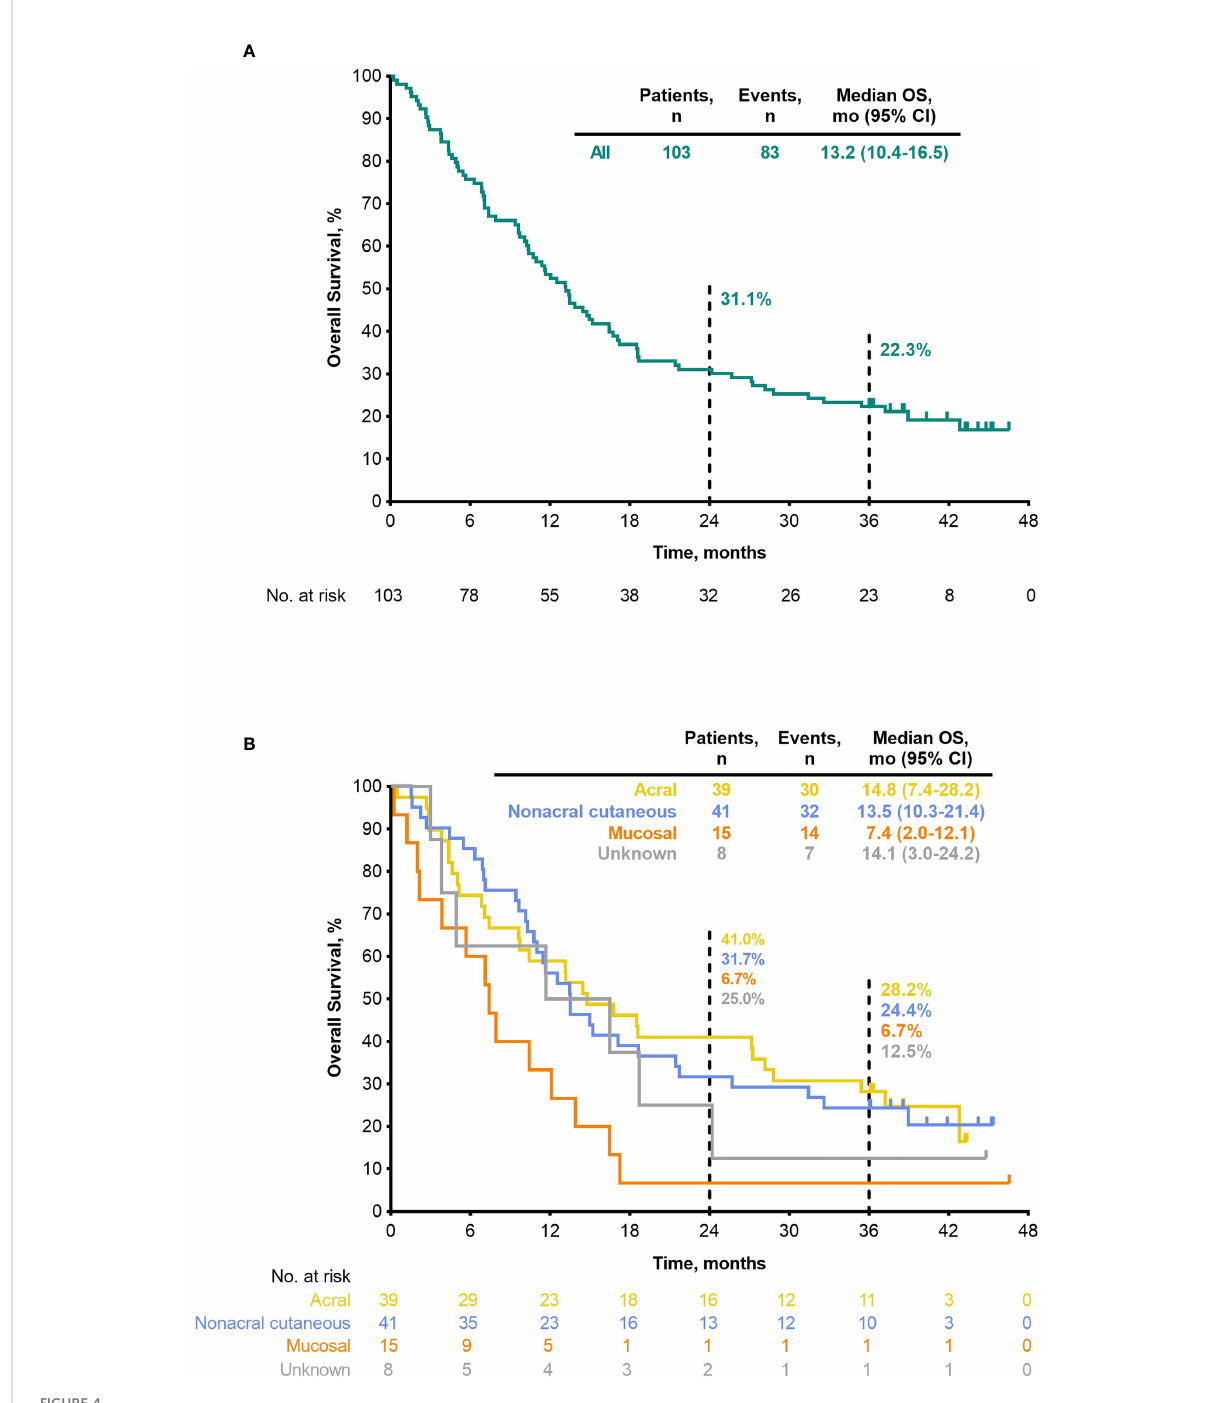
FIGURE 4 OS (ASaT population) (A) all patients (B) by melanoma subtype. ASaT, all subjects as treated; OS, overall